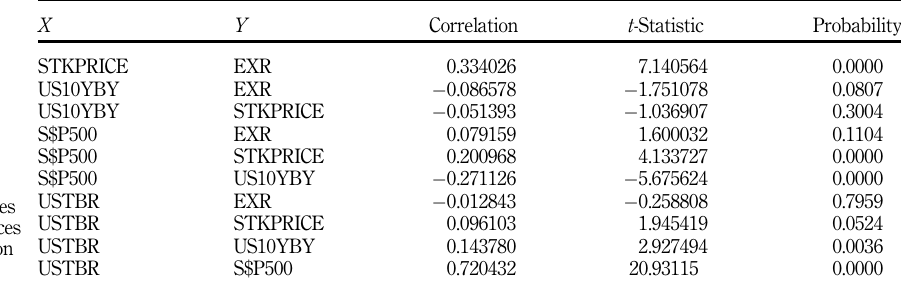
of African stock prices and US normalization policy